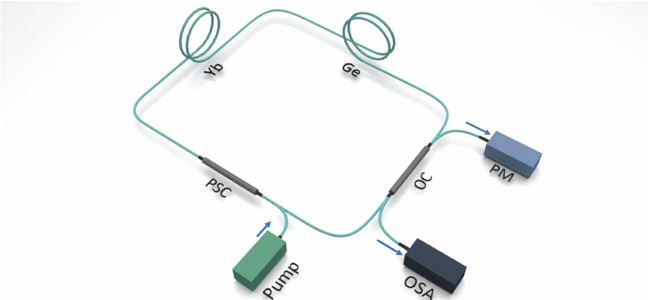
General scheme of the all-fiber ring laser. The setup consists of a pump diode (pump), pump signal combiner (PSC), an active Yb-doped fiber (Yb), a passive Ge-doped fiber (Ge), and an output coupler (OC). This cavity shows the effect of spontaneous unidirectional lasing in combination with optical bistability. Unidirectional lasing occurs far above the laser threshold for up to now unknown reasons. The final direction is not predefined. The cavity can finally switch in any of the two directions. We observed that the direction probabilities can be significantly altered by the loss sequence of the passive fiber. We composed the passive fiber by 1 km long sections of two different fibers. Both fibers are Corning’s HI 1060 fiber, share the same data sheet, and meet its requirements at the design wavelength of 1060 nm. Nevertheless, the spectral dependence is locally different due to variations in the OH